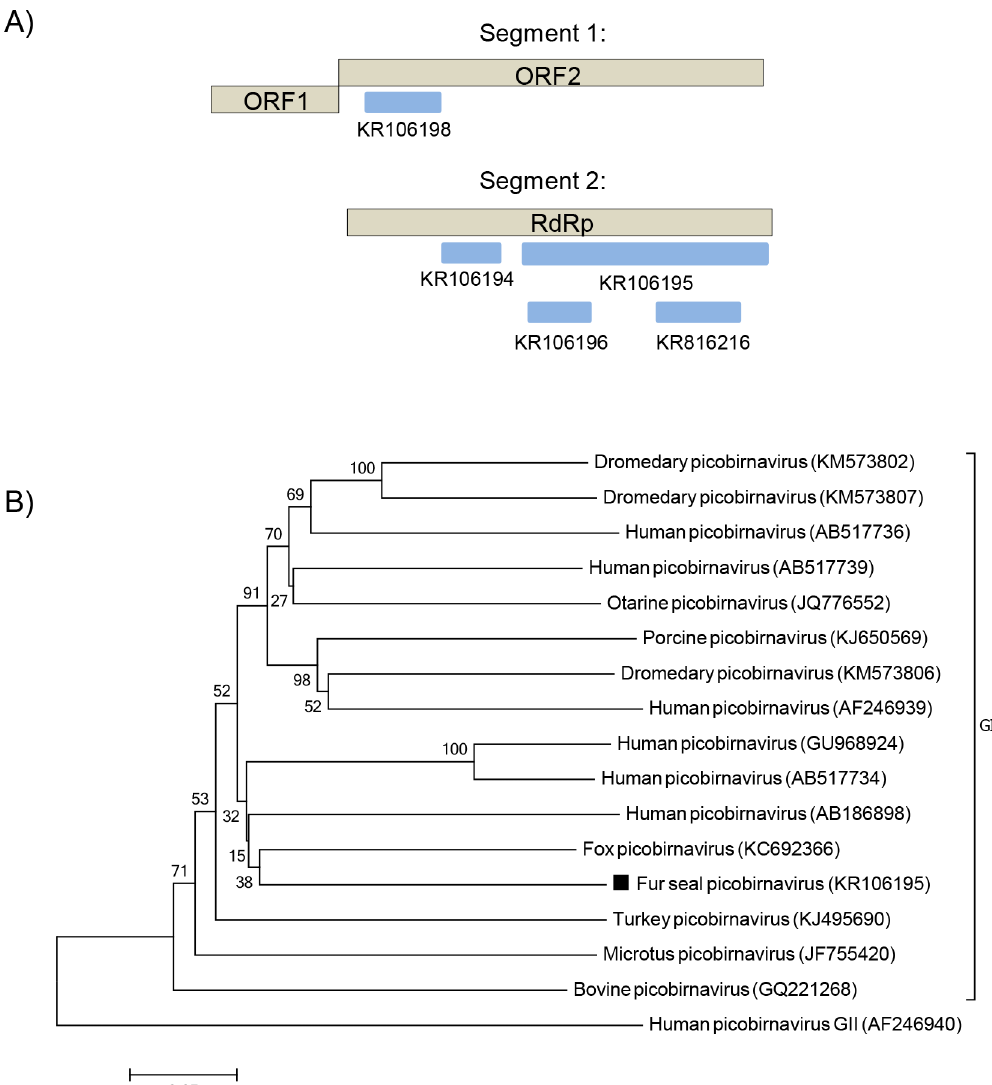
Fig 7. Phylogenetic analysis of fur seal picobirnavirus. (A) Schematic representation of the genome of picobirnaviruses using as an example the human picobirnavirus (~4.2 kb). The blue bars represent the contigs from South American fur seal. (B) Neighbor-joining phylogenetic tree based on the alignment of partial nucleotide sequences (743 bp) from the RdRp gene of 17 picobirnaviruses. Human picobirnavirus GII was used as outgroup. The picobirnavirus sequence from South American fur seal identified in this study is labeled with a black square. The GenBank accession numbers of the viral sequences are shown in